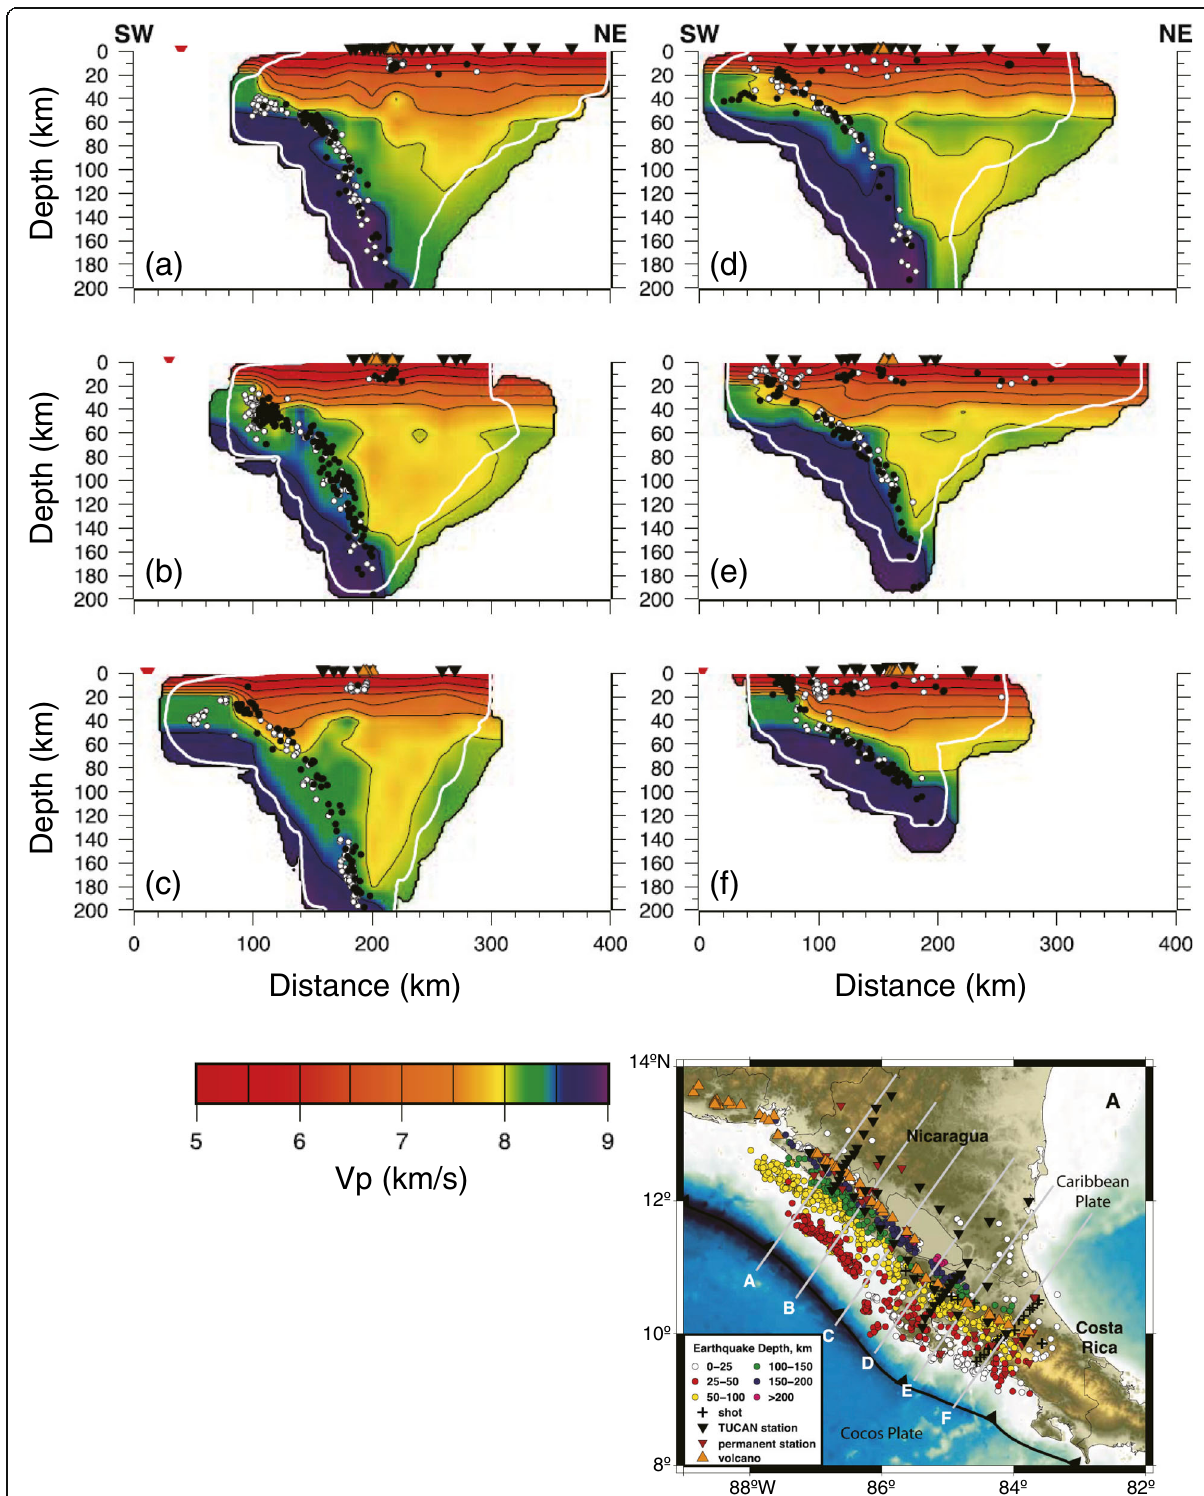
Fig. 14 P-wave velocity structure in Nicaragua and Costa Rica (Syracuse et al. 2008). P-wave velocity is shown on across-arc vertical cross-sections along lines a through f in the inset map by the color scale at the bottom . Regions surrounded by white contours contain 50 or more seismic rays. Earthquakes within 40 km to the northwest of each cross-section line are shown in white and those within 40 km to the southeast are in black. Red inverted triangles show the trench